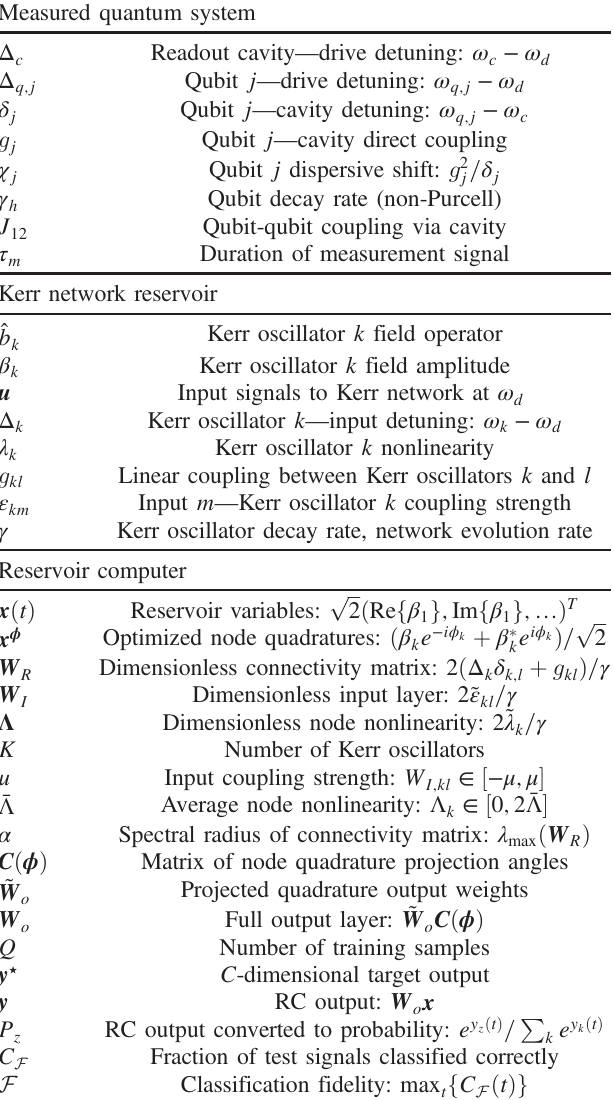
ffiffiffiffiffi κη p h d þ d † i : density matrix evolution and